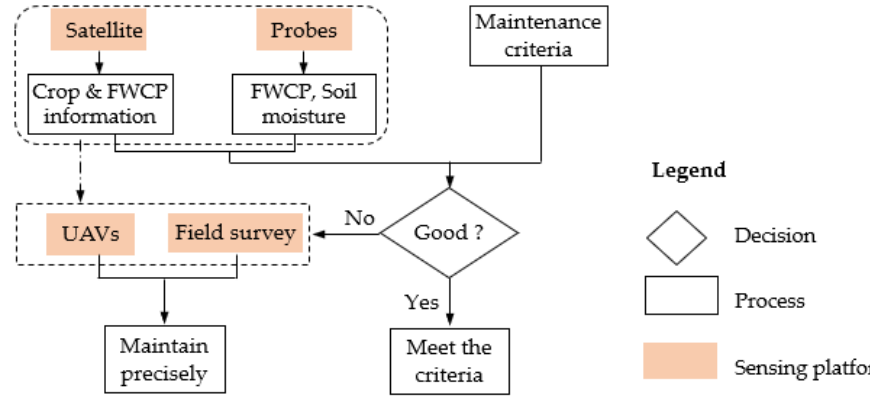
Figure 3. Flowchart for routine maintenance (the dotted arrow indicates that the sensing platforms in the round corner box with a dashed line are combined with those in the dotted rectangular box to maintain precisely due to the poor FWCP condition).